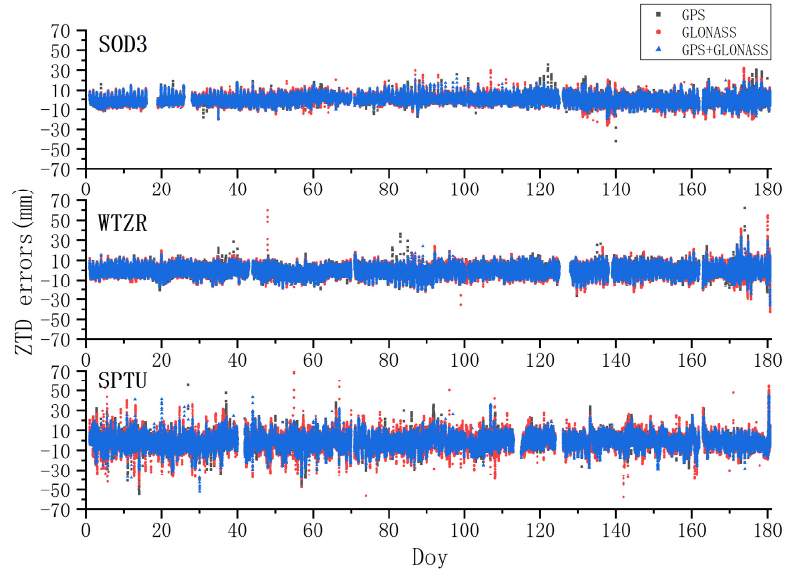
Figure 15. The ZTD error series of station SOD3, WTZR, and SPTU estimated with PPP.